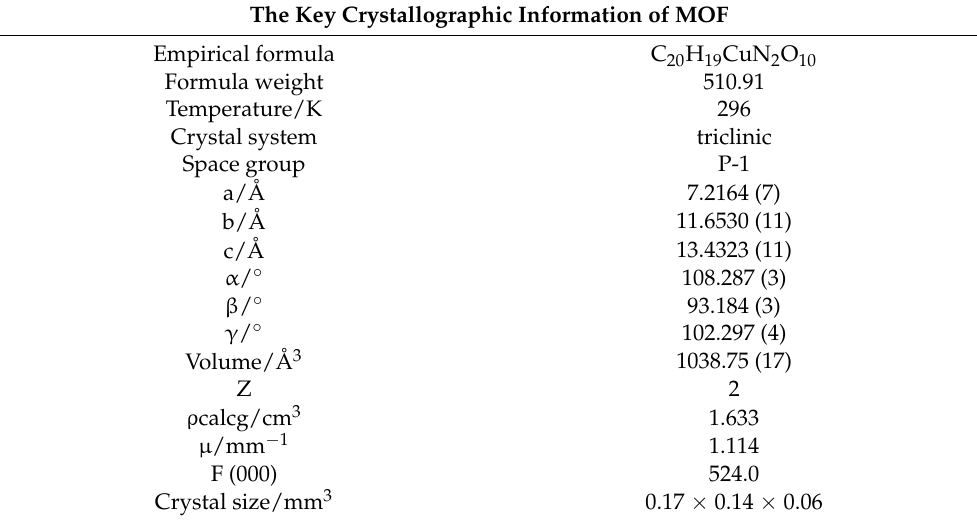
Table 1. Crystallographic data for the prepared MOF. The Key Crystallographic Information of